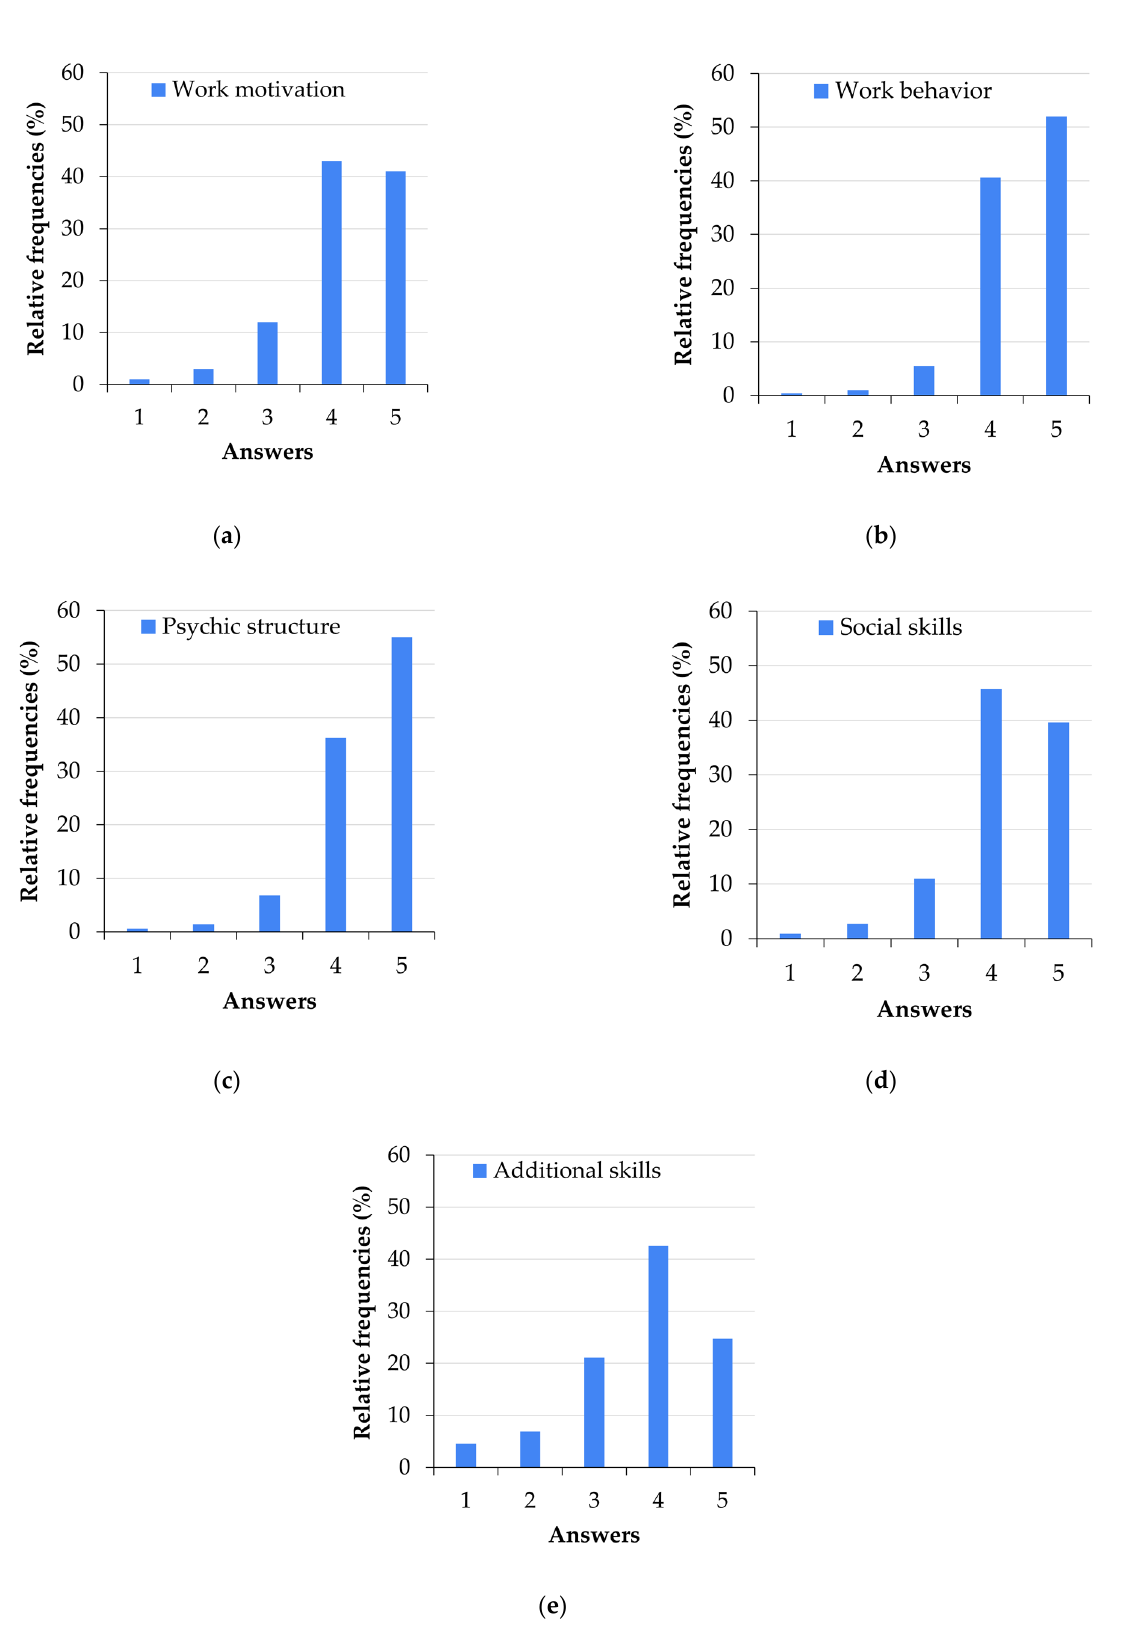
Figure 3. Bar graphs of the relative frequencies of the possible answers for the different scales: ( a ) work motivation; ( b ) work behavior; ( c ) social skills; ( d ) psychic structure; ( e ) additional